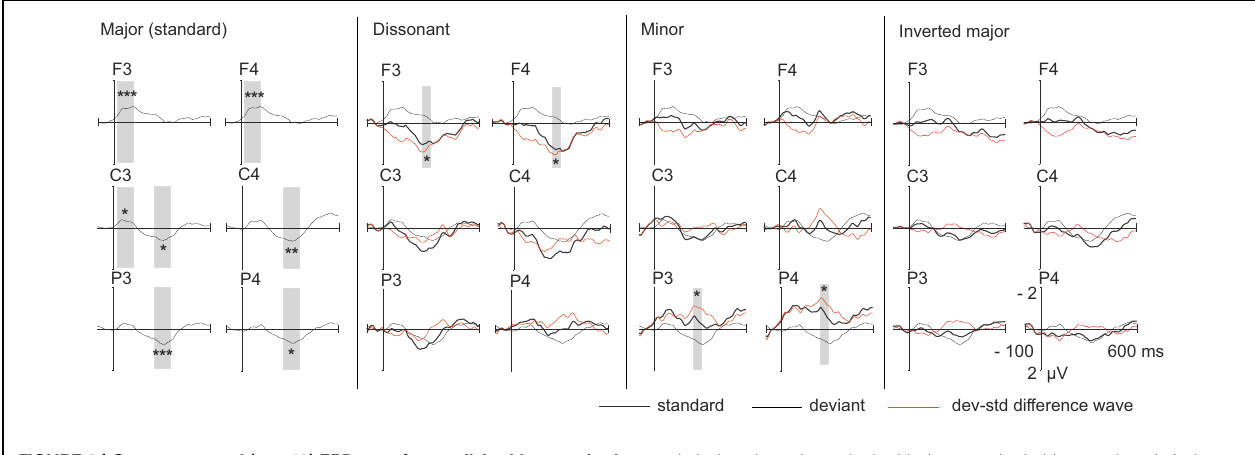
FIGURE 2 | Group-averaged ( n = 19) ERP waveforms elicited by standard (thin line) and deviant stimuli (thick line) and the deviant-minus- standard subtraction waveform (red line). The latency window used for